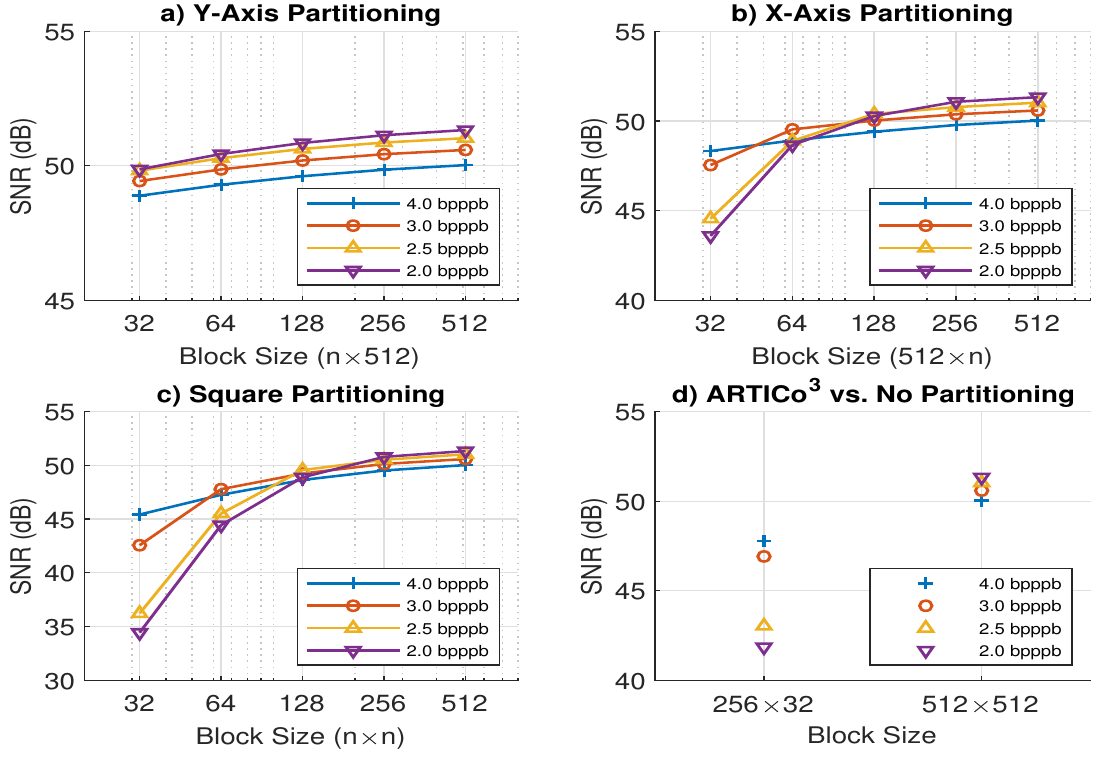
Figure 6. Image partitioning impact on Signal-to-Noise Ratio (SNR) (input versus